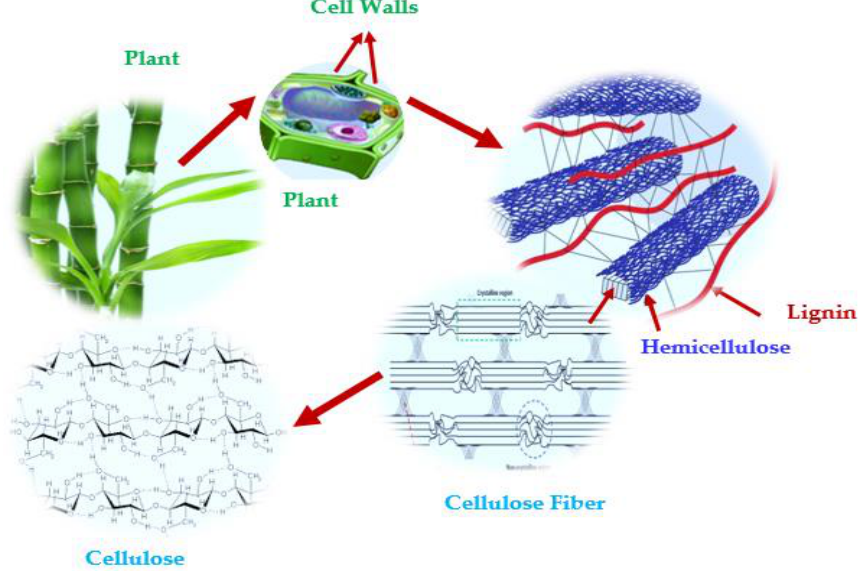
Figure 8. Chemical structure of cellulose.